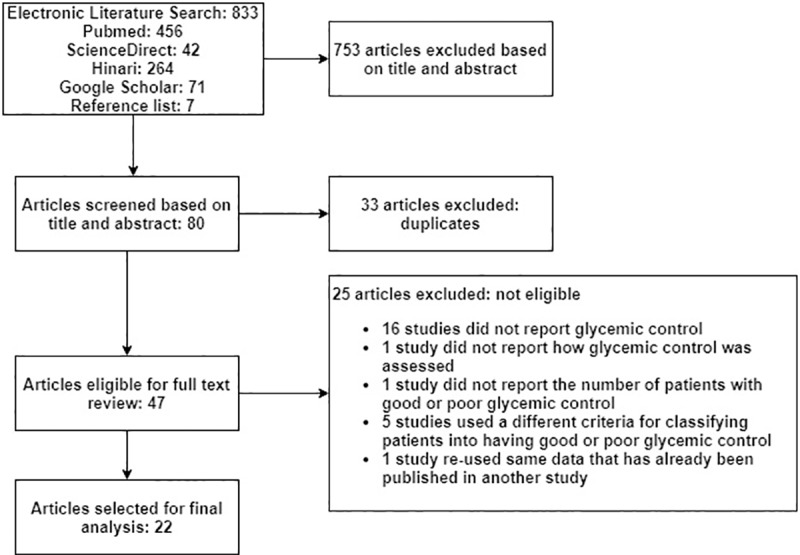
Flow diagram showing systematic literature search.